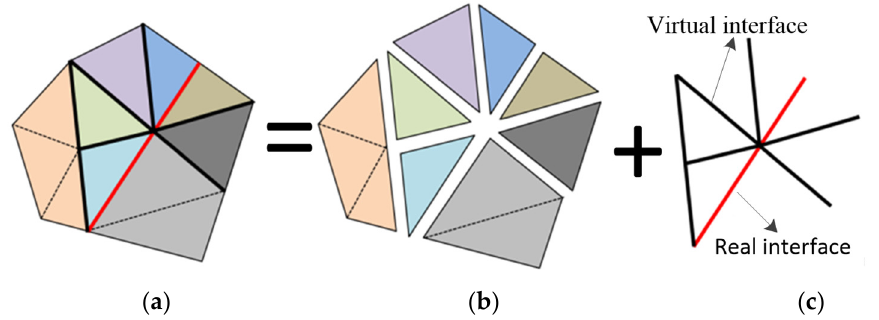
Figure 2. Model schematic of continuum–discontinuum element method: ( a ) numerical model; ( b ) block model; ( c ) interfaced model.